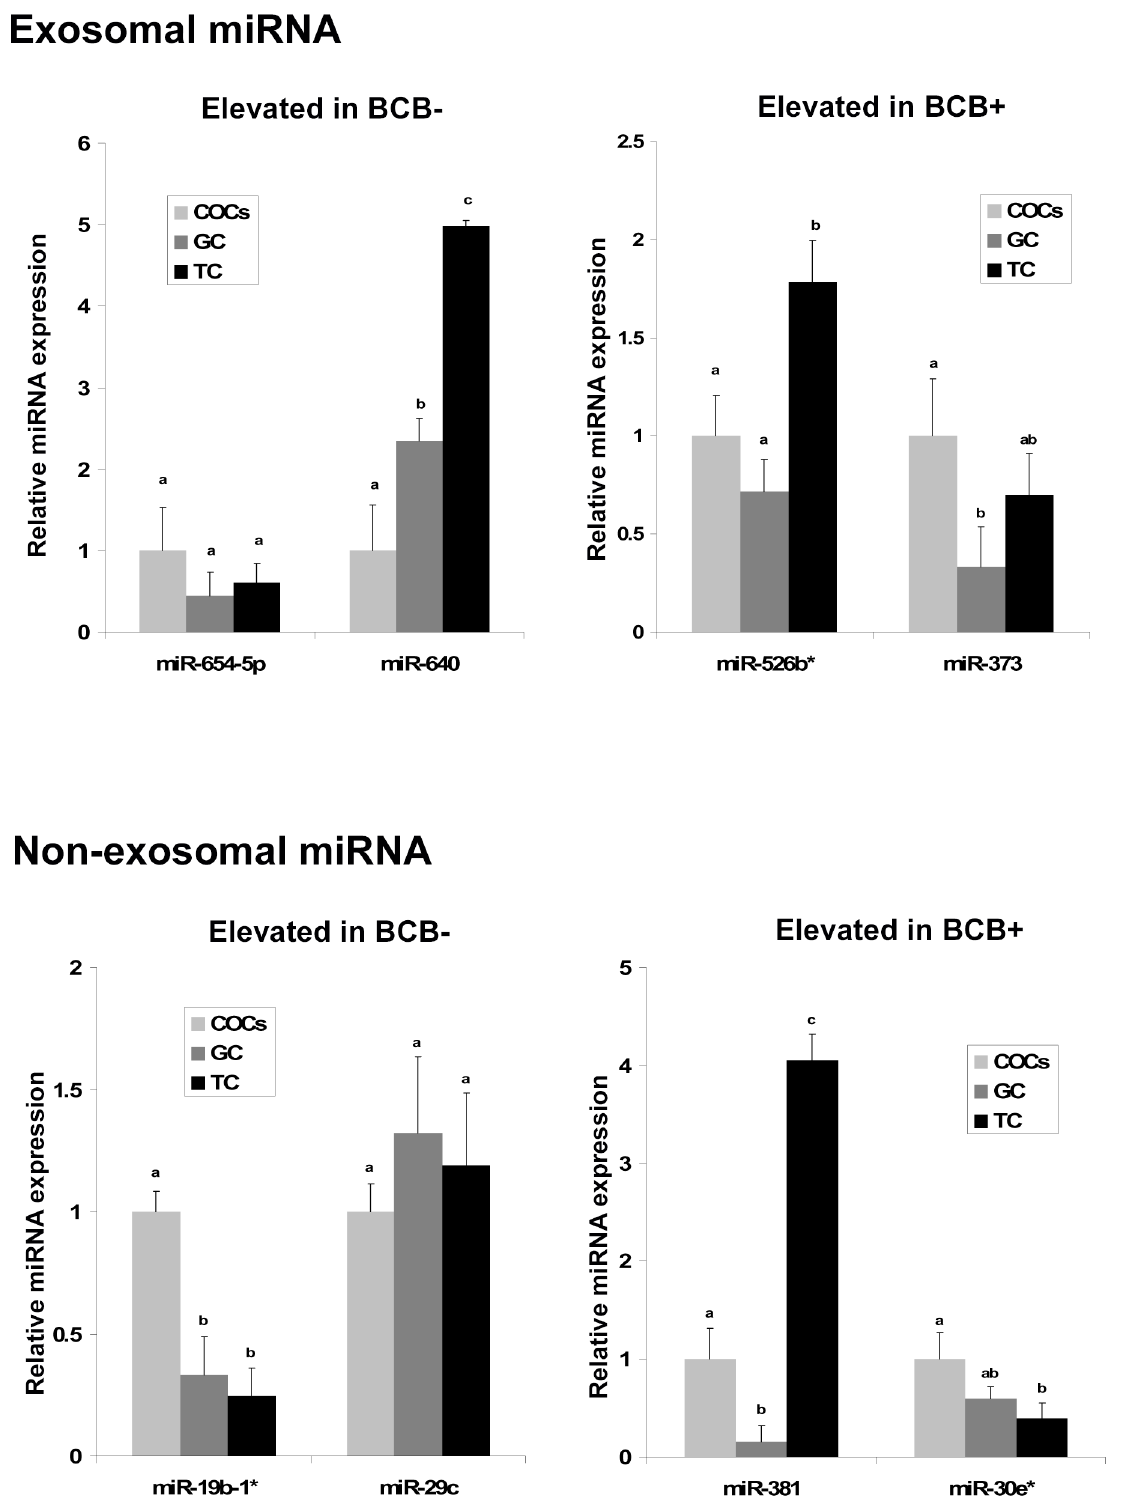
Figure 4. Analysis of exosomal and non-exosomal miRNAs in follicular cells. Expression patterns of miR-654-5p and miR-640 (up-regulated in exosomal fraction follicular fluid derived from follicles containing BCB- oocytes) and miR-526b* and miR-373 (up-regulated in exosomal fraction of follicular fluid from BCB + groups) were investigated in surrounding follicular cells namely: cumulus oocyte complex (COCs), granulosa cells (GC), and theca cells (TC) from the same category of follicle which were used for miRNA PCR array analysis. Four miRNAs namely: miR-19b-1*& miR-29c (enriched in non exosomal fraction of follicular fluid from BCB-) and miR-381 & miR-30e* (enriched in non exosomal fraction of follicular fluid from BCB + group) were also investigated for their expression in surrounding follicular cells. The data is presented as relative abundance of different miRNAs in different cell types compared to their expression in COCs as a control. Error bars represents means 6 SD of three biological replicates and